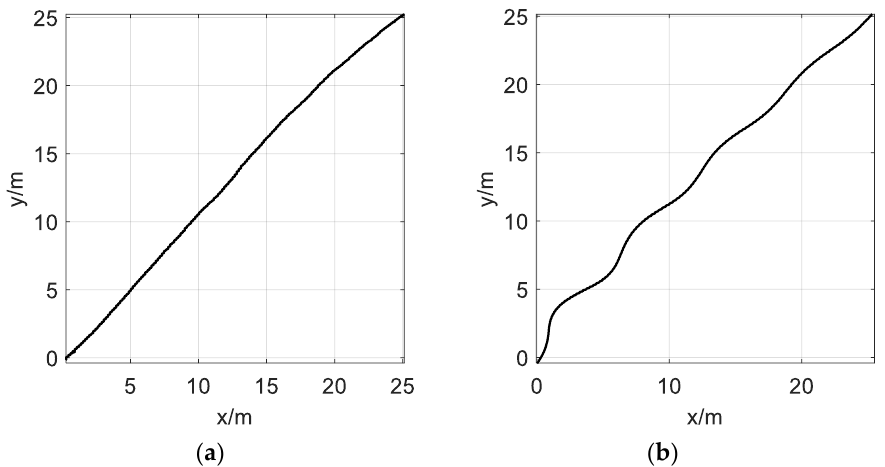
Figure 23. Practical target tracking trajectory: ( a )forward,( b )left and forward.